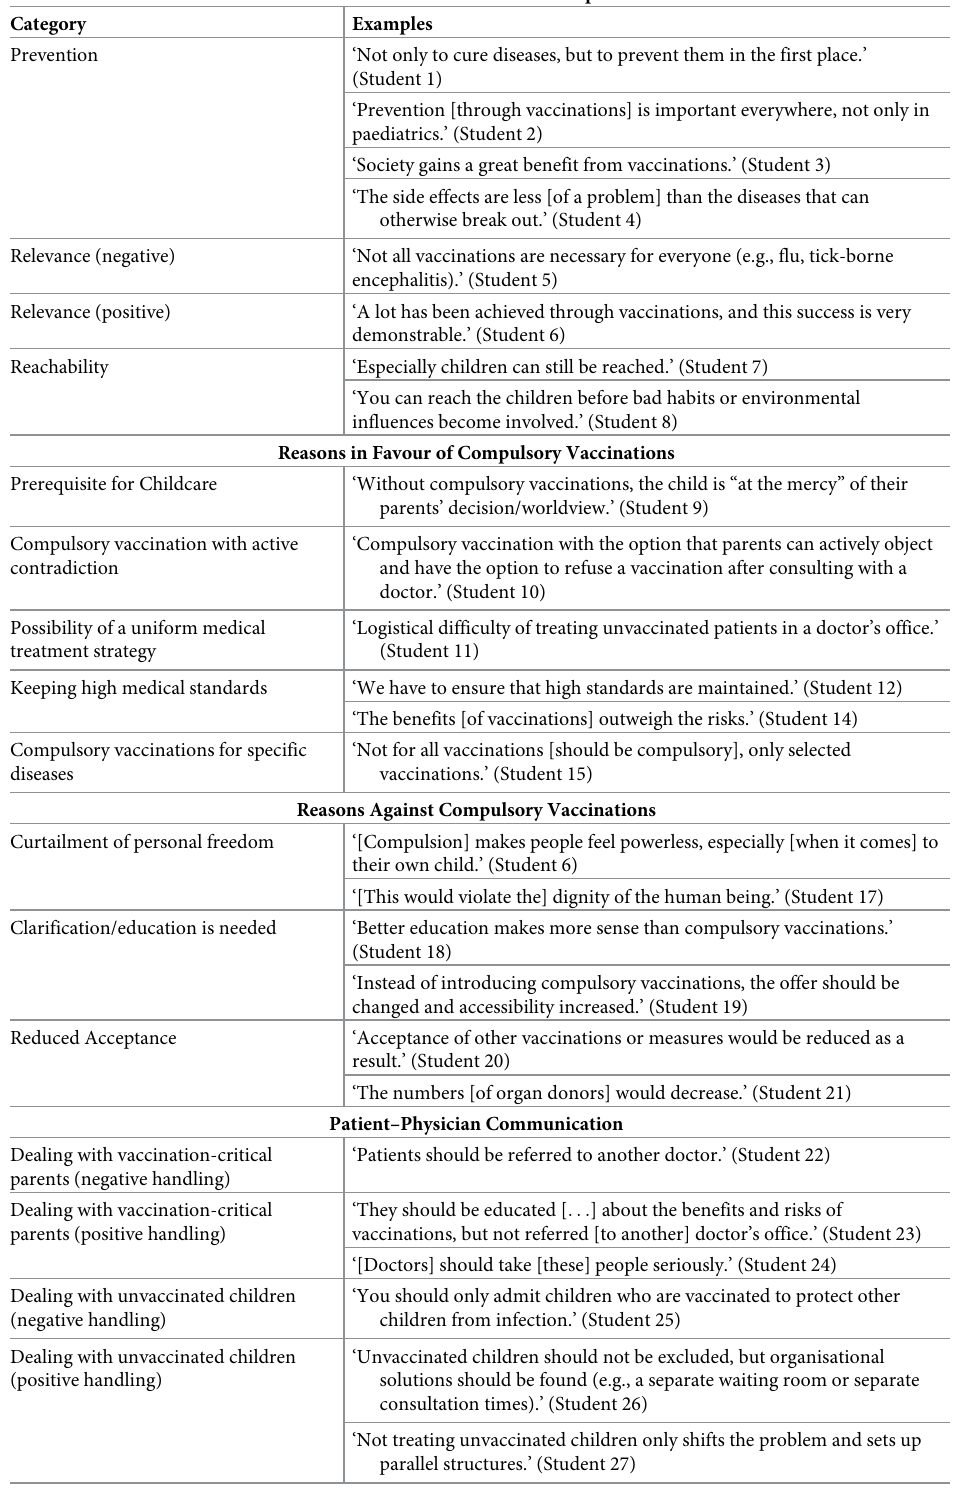
Table 2. Categories and examples from medical student focus